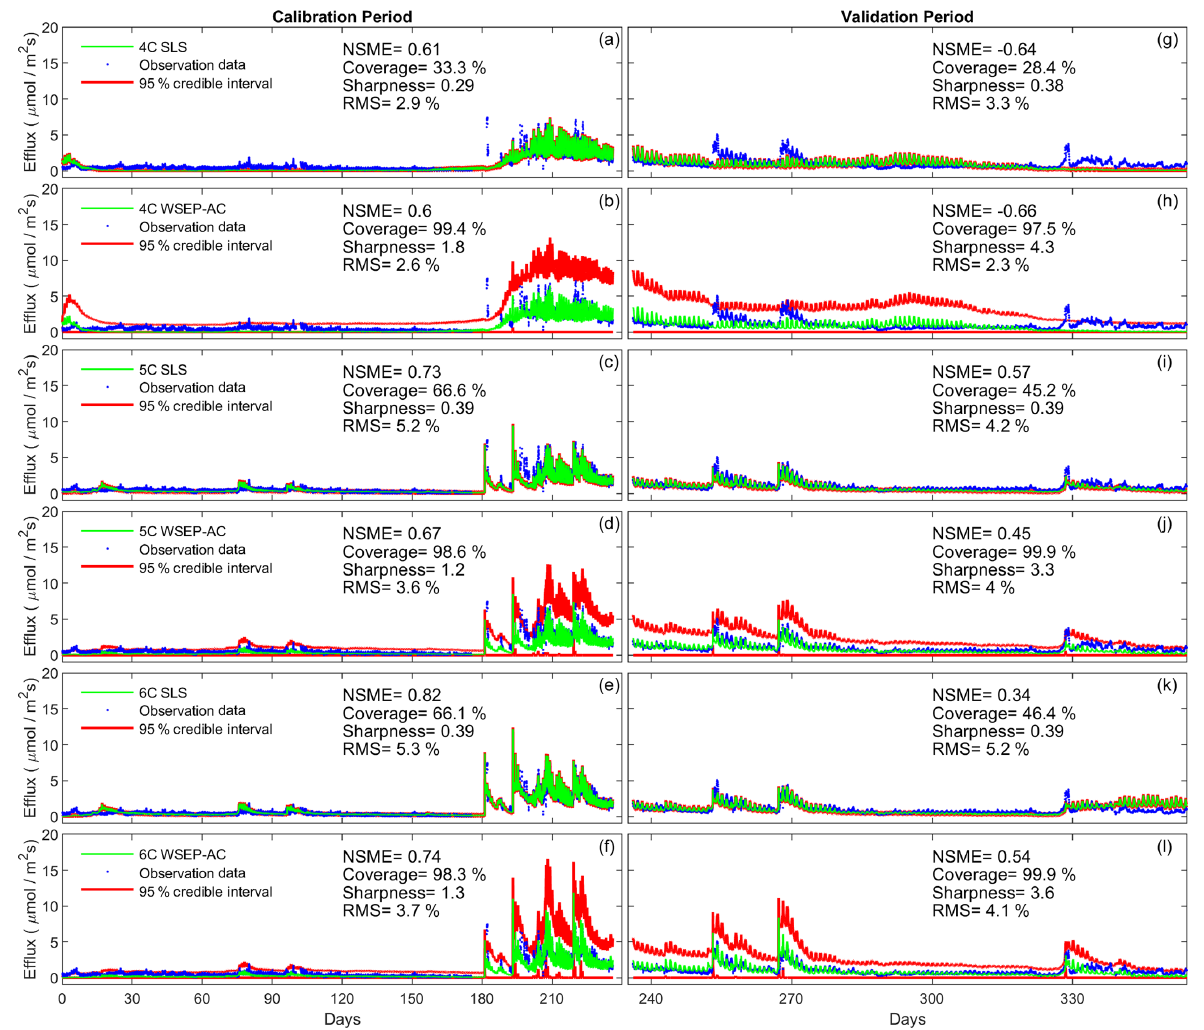
Figure 8. Observation data (blue dots), mean prediction (green line), and 95% credible intervals (red line) of prediction ensembles for (a– f) the calibration period and (g–l) the validation period. The plots are for the three soil respiration models using the SLS and WSEP-AC data models. The prediction ensembles are generated to consider parametric uncertainty of not only the soil respiration models but also the data models. The model prediction accuracy, reliability, dispersion and overall predictive performance are measured by the Nash–Sutcliffe model efficiency (NSME), the predictive coverage metric (“Coverage”), the sharpness metric (“Sharpness”) and the relative model score (RMS),